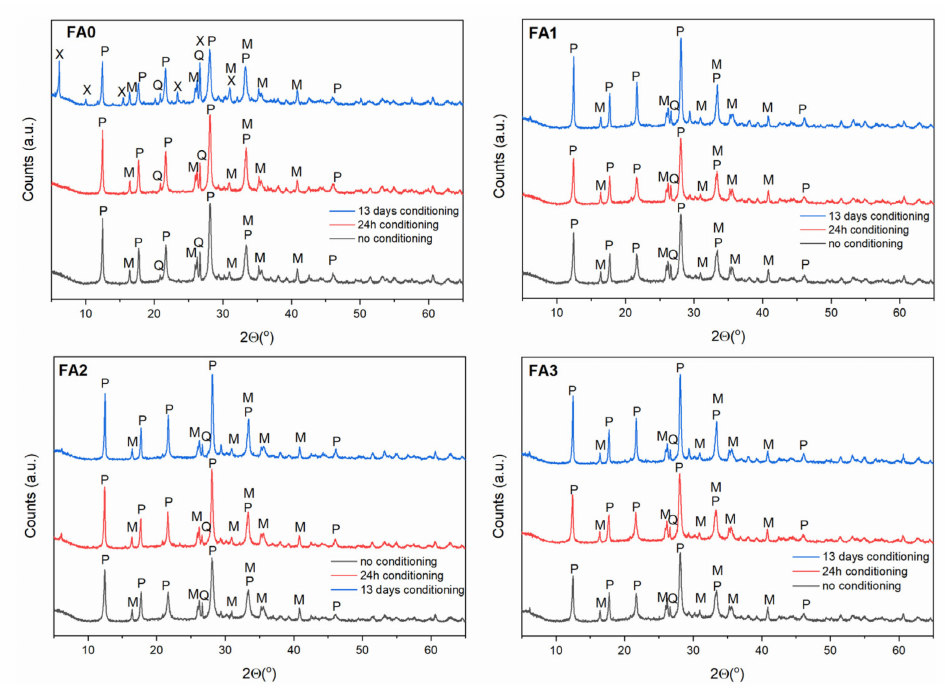
Figure 8. The effect of FA milling and solution conditioning on the FA conversion into Na-P1 zeolite phase. Clarifications: X—zeolite Na-X, M—mullite, Q—quartz, P—zeolite Na-P1.